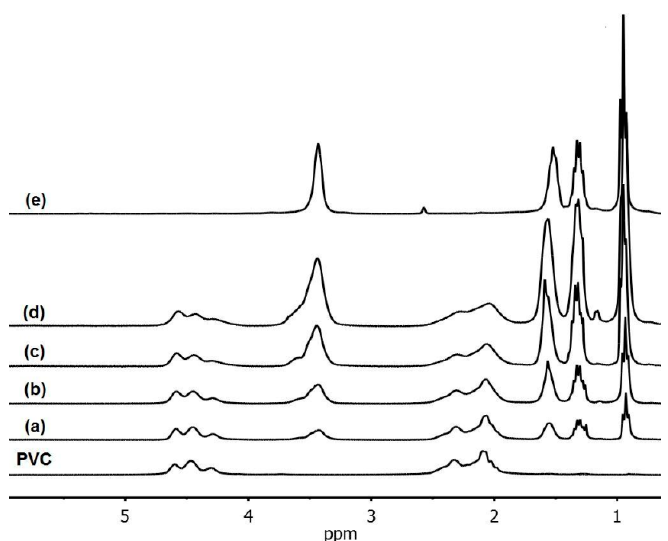
Figure 4. 1 H-NMR spectra of PVC modified with different amounts of compound 7 . ( a ) 6 mol %; ( b ) 11 mol %; ( c ) 22 mol%; ( d ) 34 mol%, and ( e ) pure compound 7 .